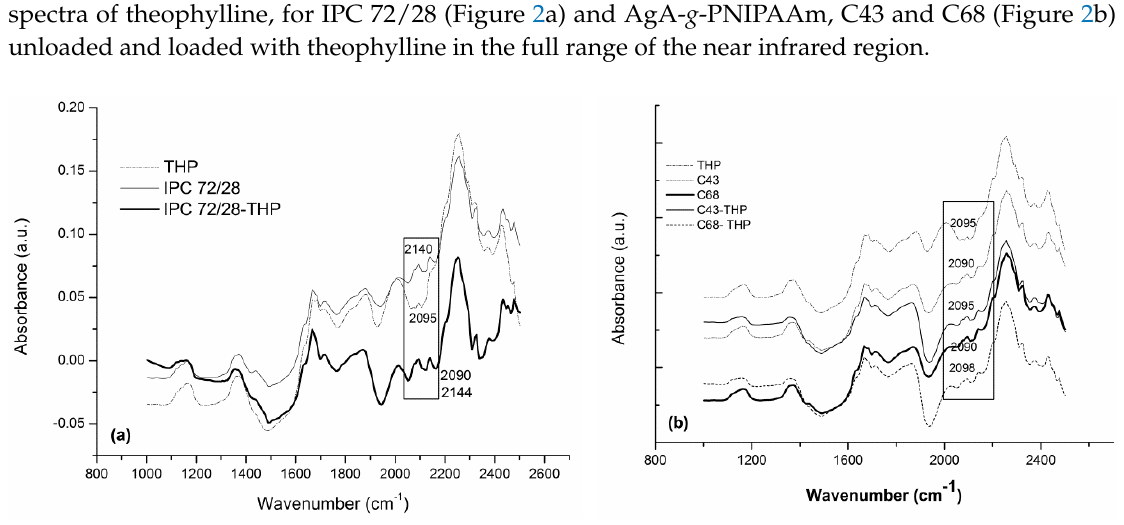
Figure 2. NIR spectra of theophylline, for IPC 72/28 ( a ) and AgA- g -PNIPAAm, C43 and C68 ( b ).